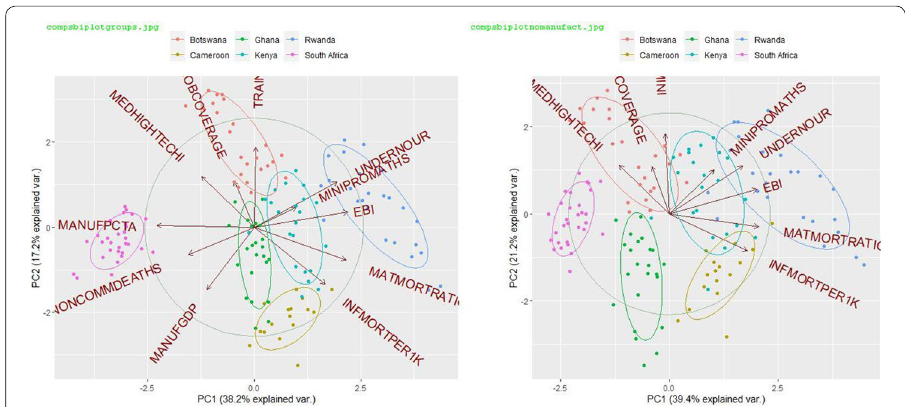
Fig. 4 The LHS and RHS panels are with and without manufacturing related variables respectively